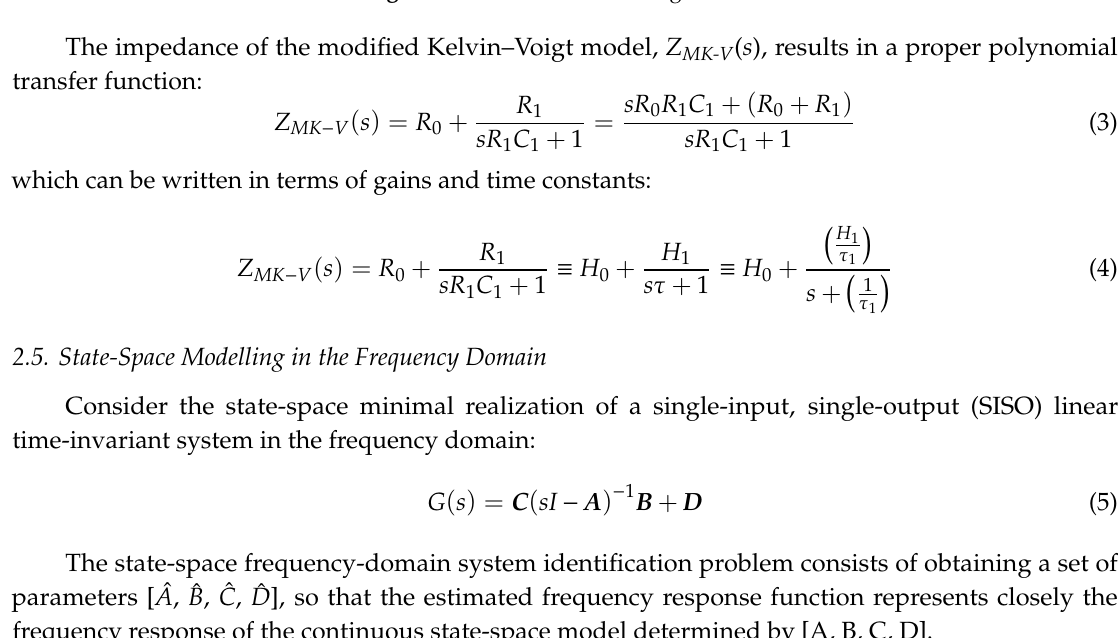
Figure 4. Modified Kelvin–Voigt model.